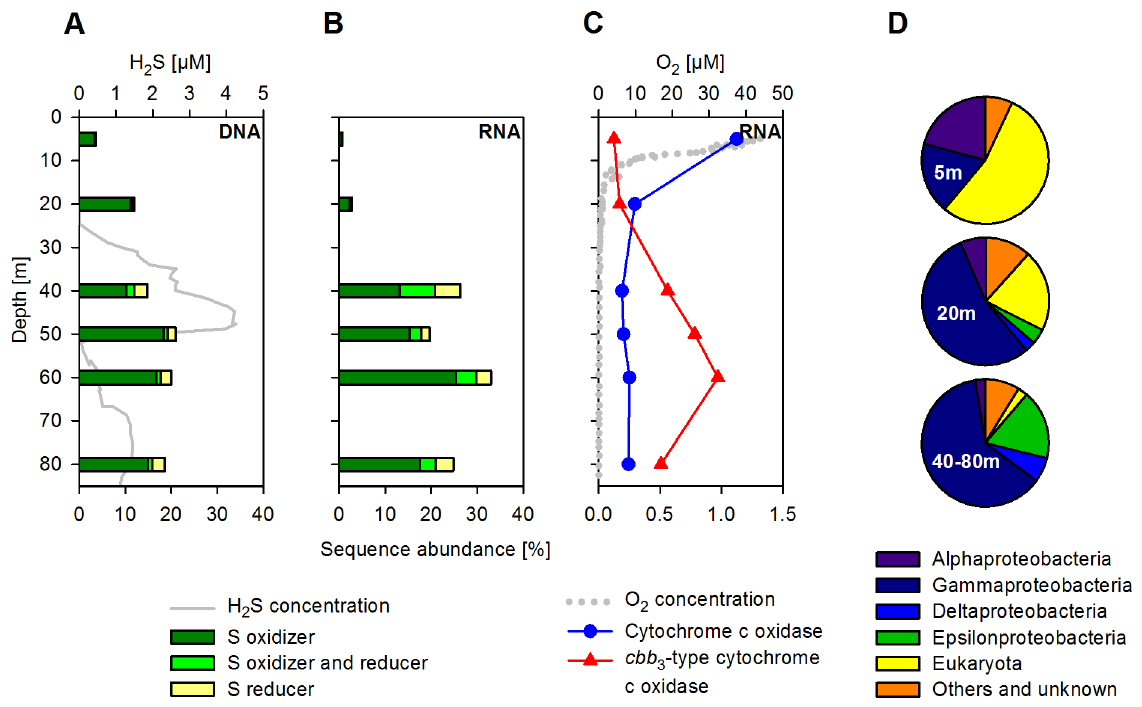
Figure 6. Vertical distribution of organisms involved in the sulfur cycle and abundance and taxonomic affiliation of transcripts encoding for cytochrome c oxidases. (A) H 2 S concentration and abundance of DNA sequences affiliated to organisms either capable of oxidizing or reducing inorganic sulfur species. Shown in percent of all DNA sequences (excluding rRNA genes) and summed according to their metabolic potentials. (B) Abundance of RNA sequences affiliated to organisms either capable of oxidizing or reducing inorganic sulfur species. Shown in percent of all RNA sequences (excluding rRNAs) and summed according to their metabolic potentials. (C) O 2 concentrations and transcript abundance of the (low-affinity) cytochrome c oxidase and the (high-affinity) cbb 3 -type cytochrome c oxidase (both EC 1.9.3.1). Shown in percent of all protein-coding RNA sequences. (D) Phylogenetic affiliation of the transcripts encoding for both types of the cytochrome c oxidase.